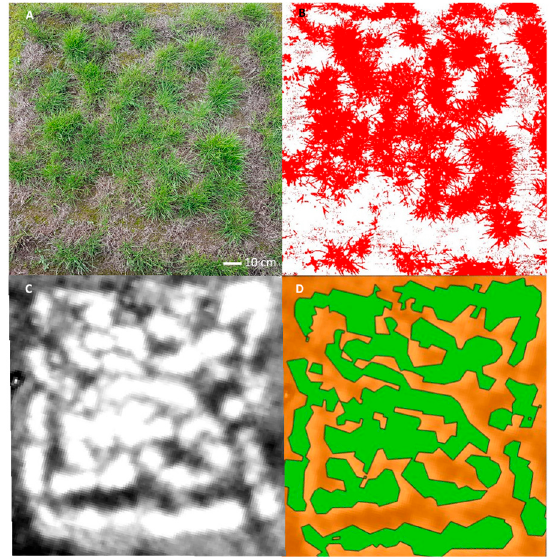
Figure 4. Comparison of perennial ryegrass ground cover classification in ImageJ and eCognition developer software; a, b, c and d images represent plot no 3. ( A ) RGB image (12 megapixels) from nadir position; ( B ) converted RGB image using HSB colour space settings in ImageJ where red represents perennial ryegrass ground cover and white c represents weed and soil; ( C ) NDVI reflectance raster image; ( D ) object-based ground cover classification in eCognition developer where green represents perennial ryegrass ground cover, and orange represents soil and weed.